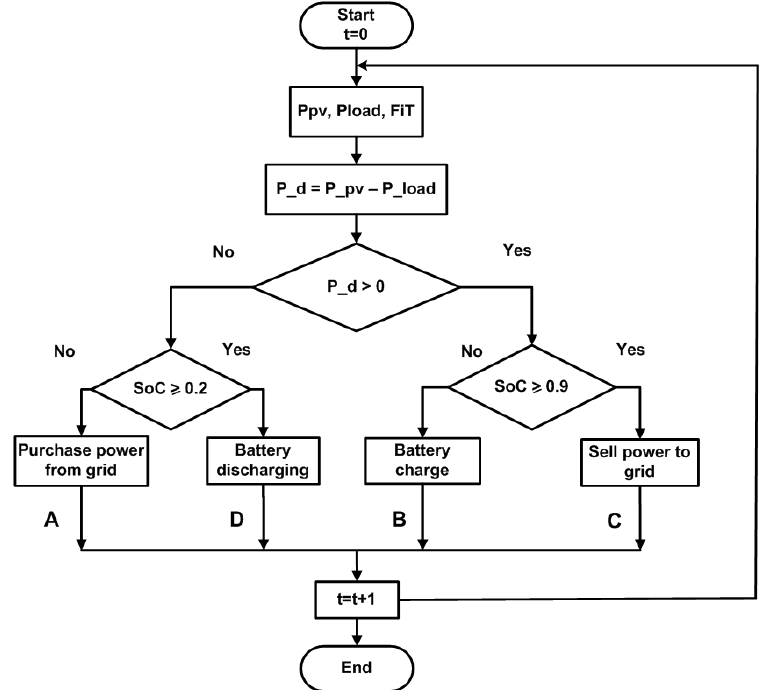
Figure 5. The flowchart for operation